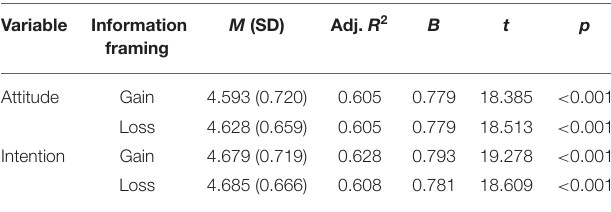
TABLE 5 | Results of linear regression analysis. Variable Information